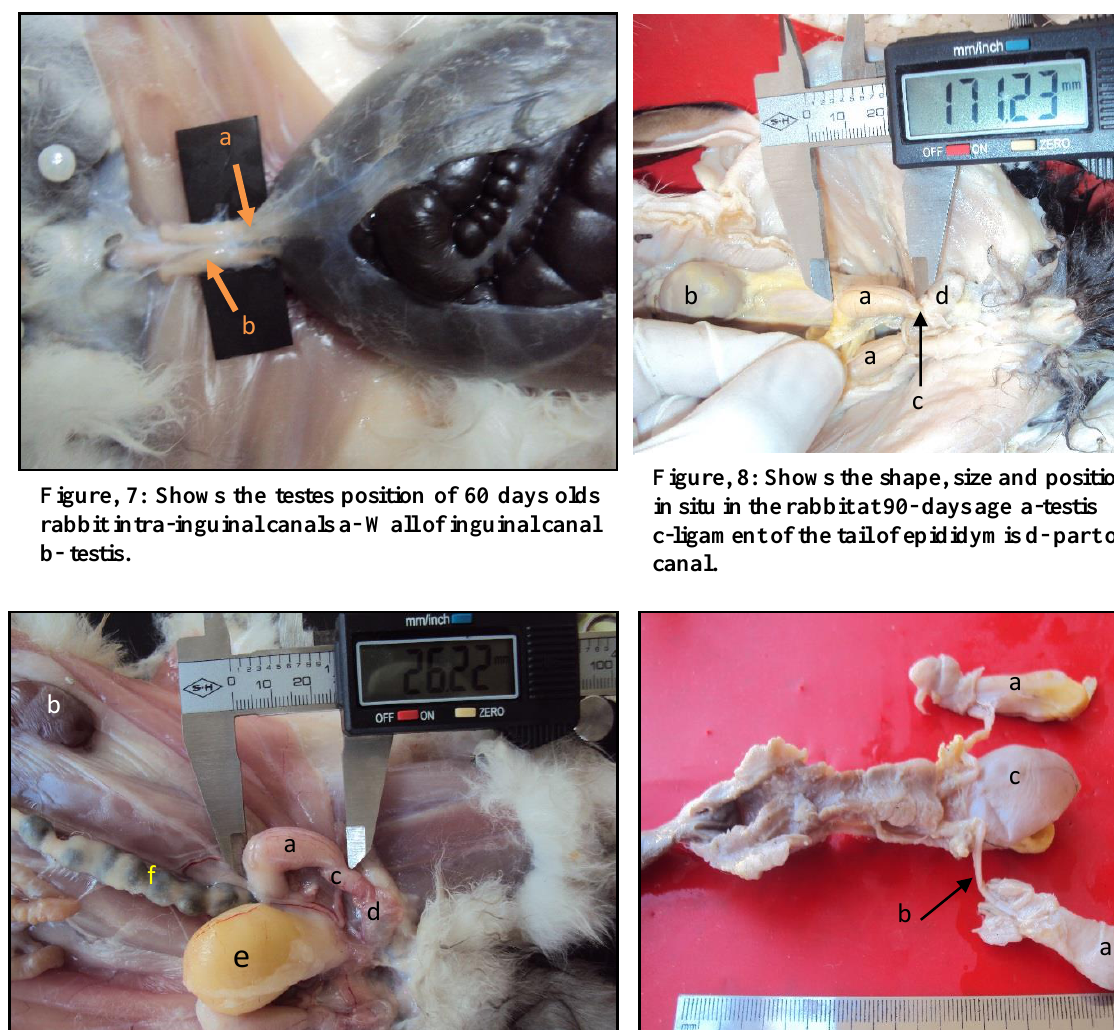
Figure, 5: Shows topographic location of the testes at 30 days old rabbit kits descent to intra-inguinal canals.